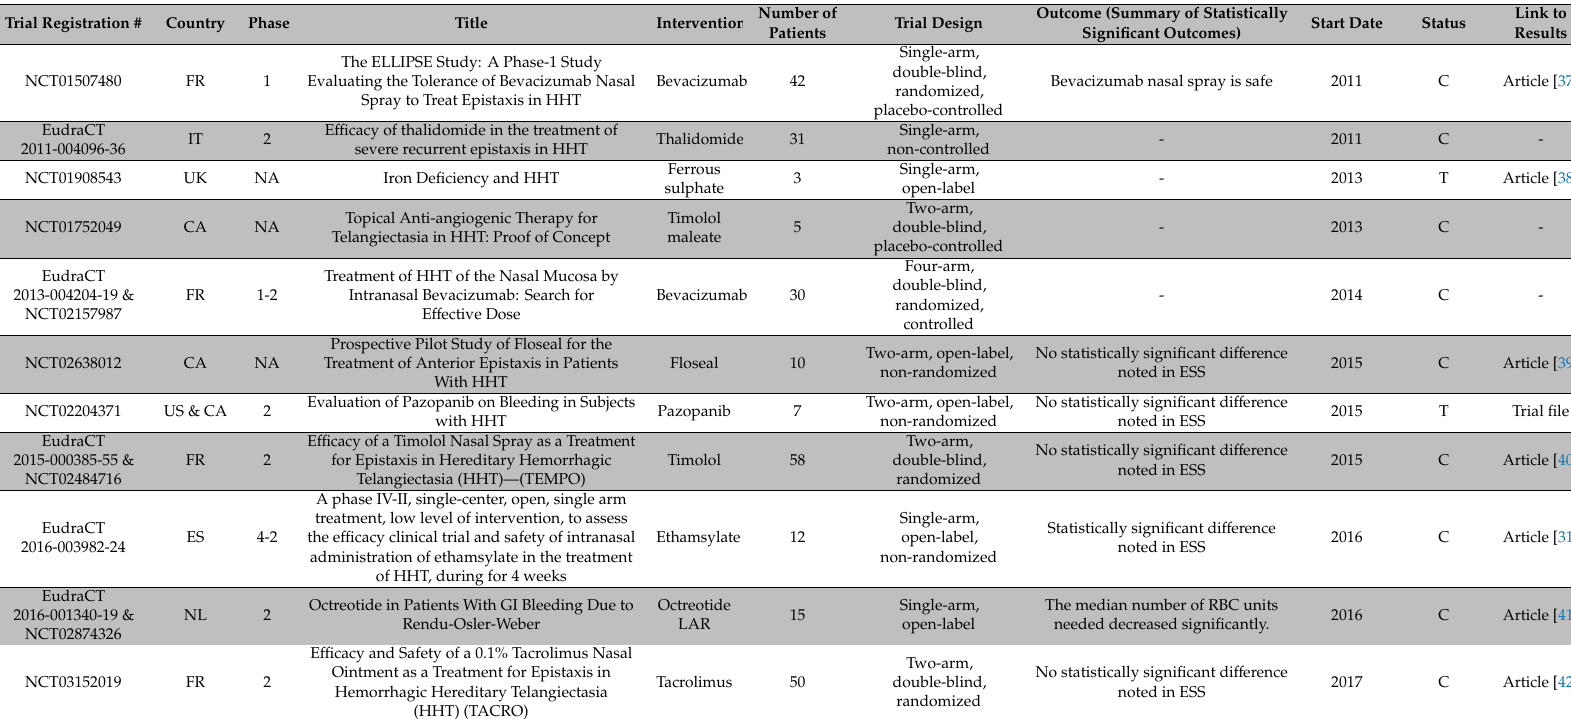
Table 3. Compilation of the Completed or Terminated HHT interventional clinical trials registered at the EU Clinical Trials Register (EudraCT) (https: // www.clinicaltrialsregister.eu), the U.S. National Library of Medicine (NCT) (https: // clinicaltrials.gov). Only interventional trials where a therapeutic drug was tested are listed. Abbreviations: Countries: AT (Austria); CA (Canada); ES (Spain); FR (France); IL (Israel); IT (Italy); NL (Netherlands); UK (United Kingdom); US (United States of America). Phase: NA (Not Applicable). Status: C (Completed) and T (Terminated). Outcome: ESS (Epistaxis Severity Score). * The Study Record Detail from the website refers to the number of patients in